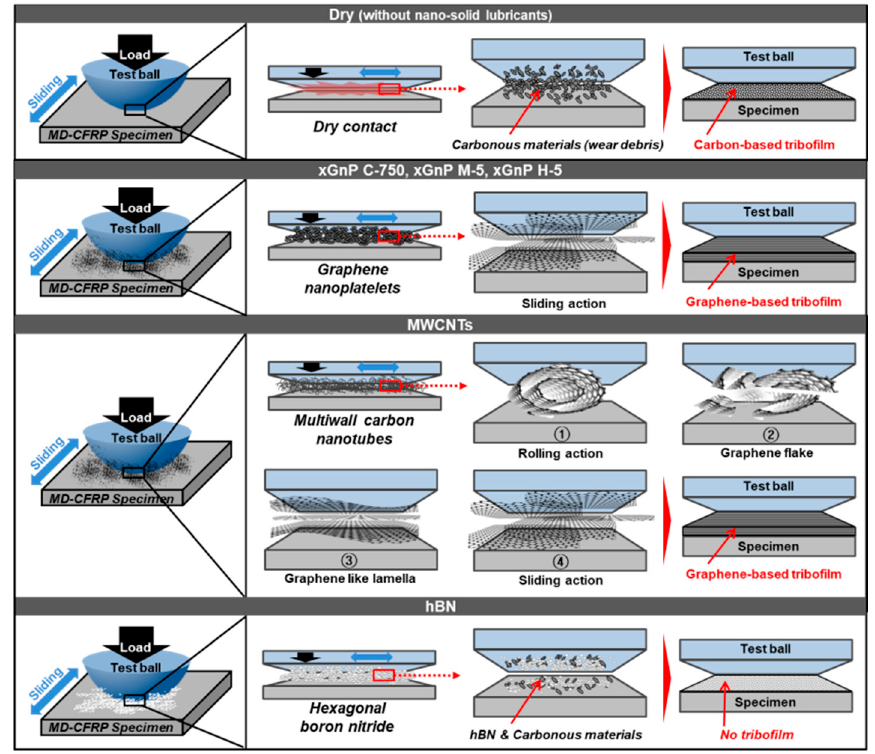
Figure 7. Primary lubrication mechanism in each case during the ball on plate